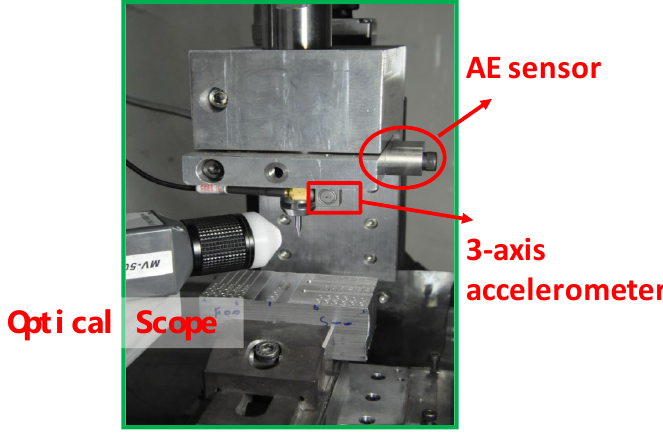
Figure 1. Experimental setup for sensors in micro milling.